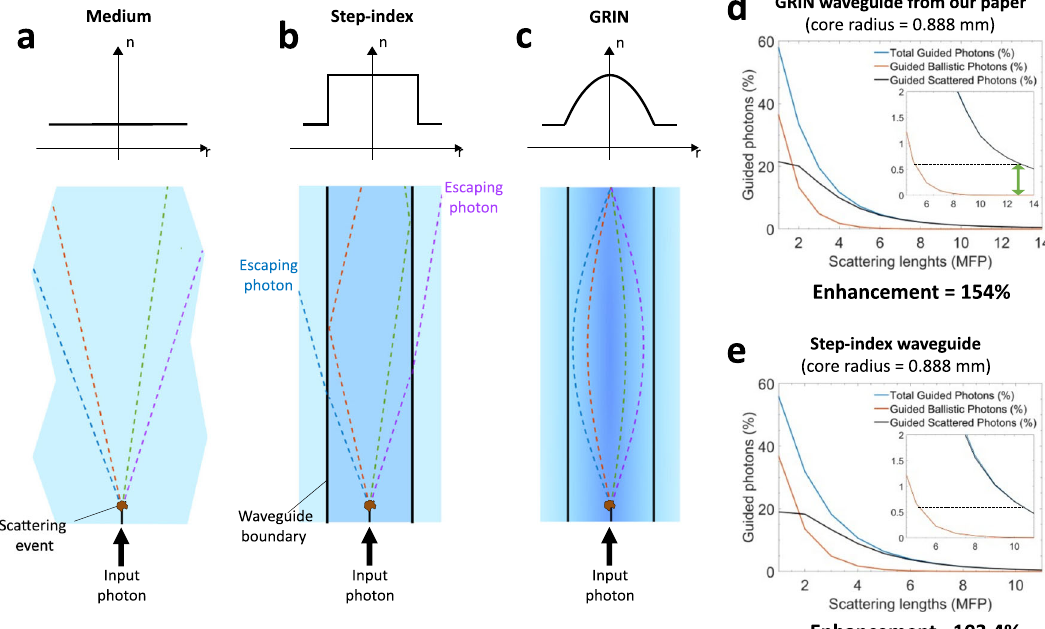
Fig. 1 Difference in guiding scattered photons between step-index and GRIN waveguides. Schematic showing optical ray tracing after a scattering event in ( a ) a simple medium, ( b ) a step-index waveguide, and ( c ) a GRIN waveguide. When a photon undergoes a scattering event in the medium, it is de fl ected and dispersed. If the same scattering event happens within a step-index waveguide core ( Δ n = 0.002), the scattered photon will travel to the waveguide core-cladding interface, where it can either escape the waveguide or de fl ect back into the core by total internal re fl ection, depending on the scattering angle. In a GRIN waveguide with ( Δ n = 0.002), scattered photons are continuously refracted and rerouted towards the target location. d Percentage of scattered, ballistic, and total photons at different optical depths for a virtual GRIN waveguide (Ultrasound ON) with Δ n = 0.002. The penetration improvement at 0.6% caused by guided scattered photons is 154%. The green arrow shows the difference between total guided photons and guided ballistic photons. e When the same parameters are used for a step-index waveguide, the penetration improvement is reduced to